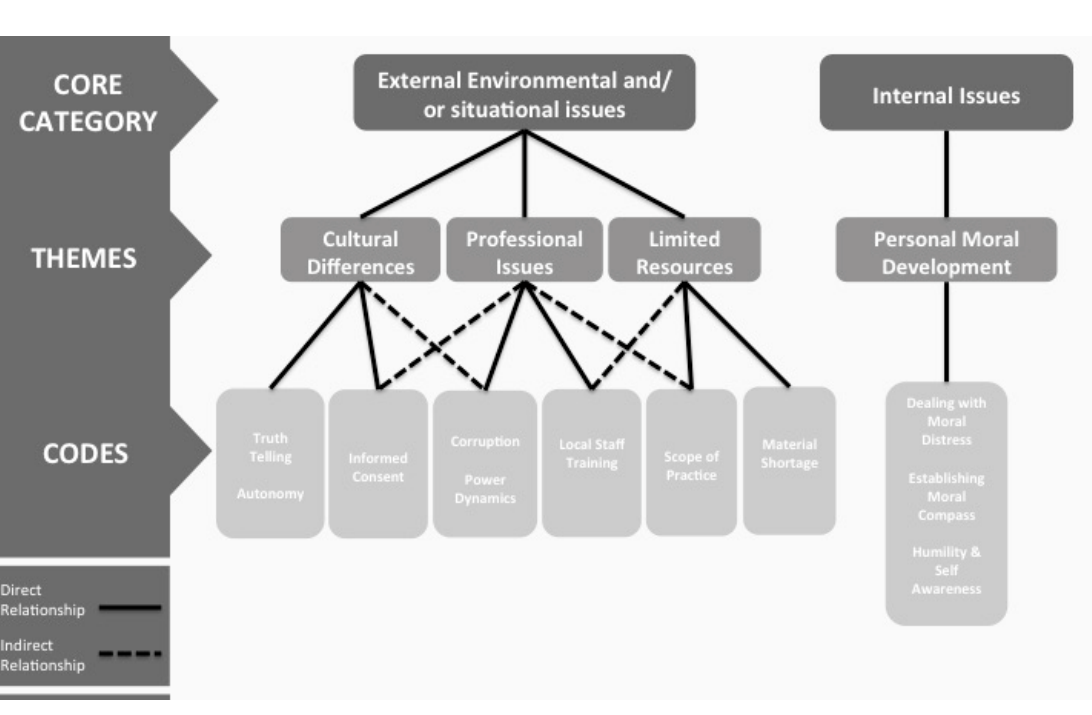
Figure 1 . A summary of the ethical dilemmas (codes). Figure 1. A summary of the ethical dilemmas